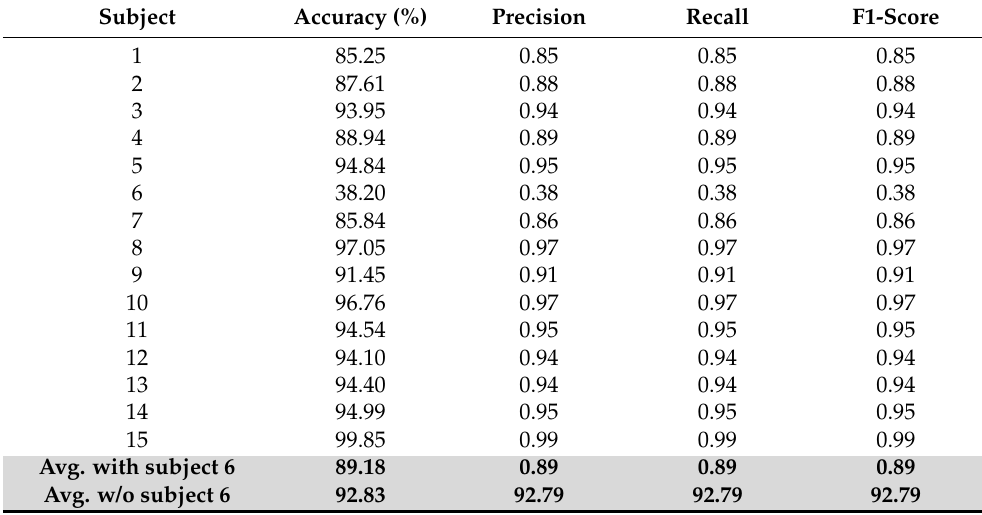
Table 8. Subject-wise results for SEED dataset (3 classes) using 3D-CNN + ELM